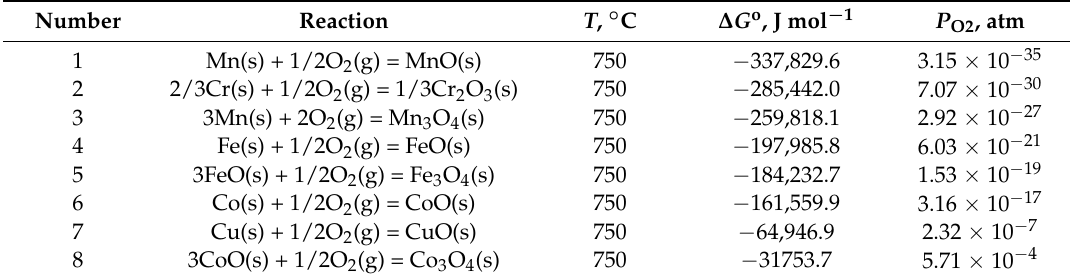
Table 3. Standard free energies ( ∆ G o ) of reactions and oxygen partial pressure ( P O2 ) at equilibrium at 750 ◦ C. ∆ G o values for the mole numbers are shown in the chemical